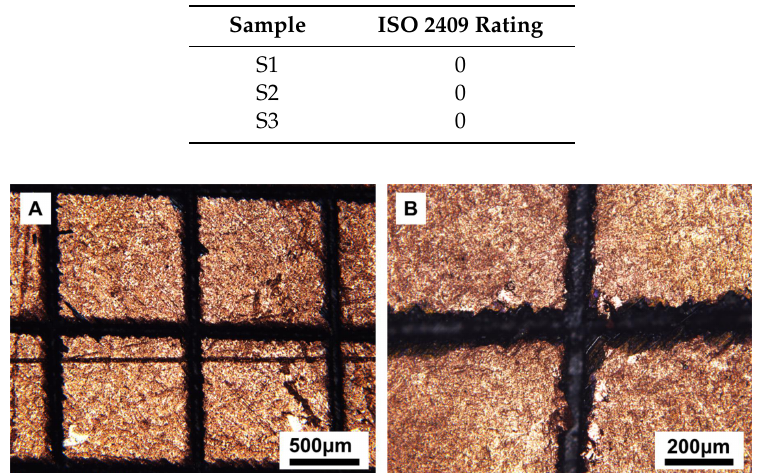
Table 2. Cross-cut test classifications according to ISO 2409.